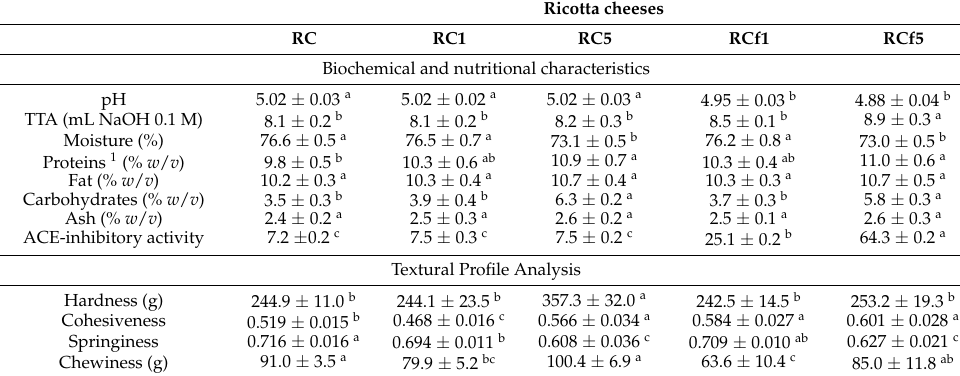
Table 5. Biochemical, nutritional, and textural characteristics of the ricotta